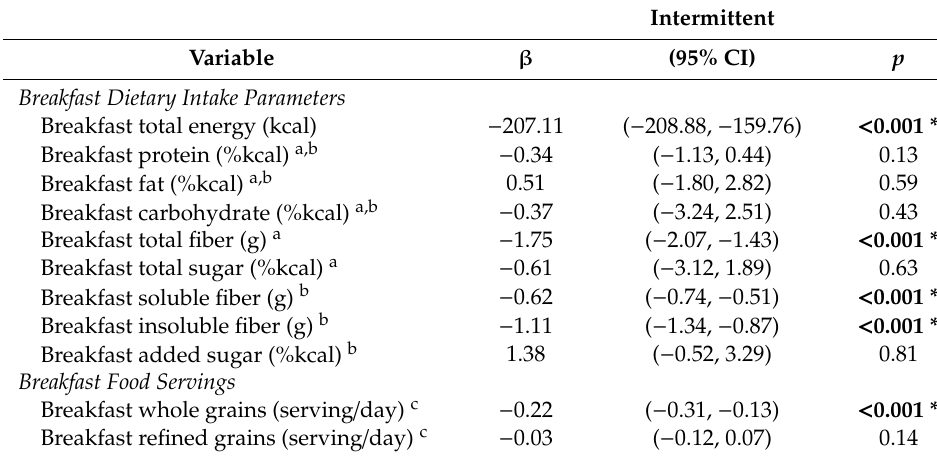
Table 5. Multivariate regression models of breakfast nutrient intake and breakfast food servings with regular consumers as the referent group ( n =